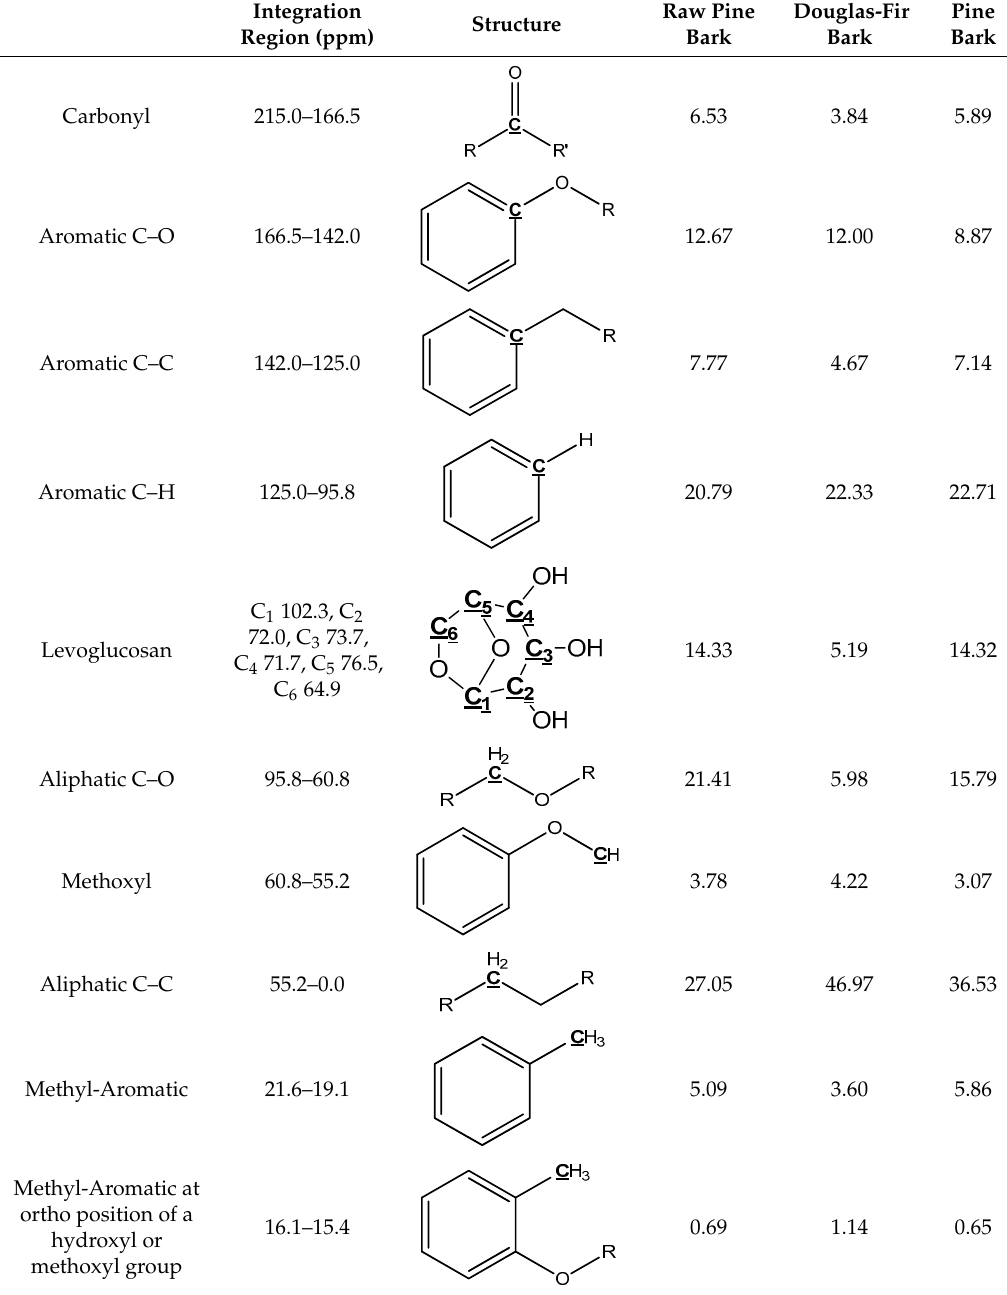
Table 7. Integration results shown as the percentage of carbon of pyrolysis oils produced from raw pine bark, pine, and Douglas-Fir bark at 500 °C. 1 Raw Pine Douglas-Fir Pine Integration 1 Structure O Region (ppm) Bark Bark Bark C C 2